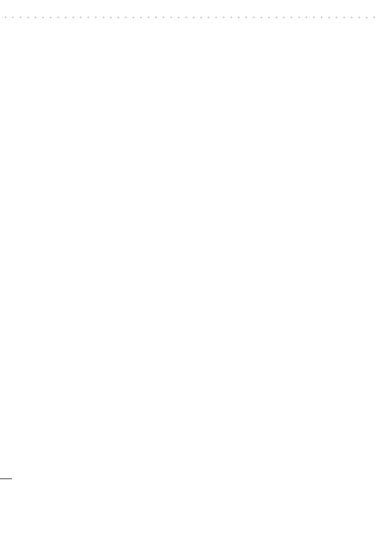
Figure 4. Swarm plots of data quality score distributions for the inpatient cohorts of ( a ) BCH (N = 832), ( b ) KCL (N = 29), ( c ) MCR (N = 19), and ( d ) UKF (N = 169).